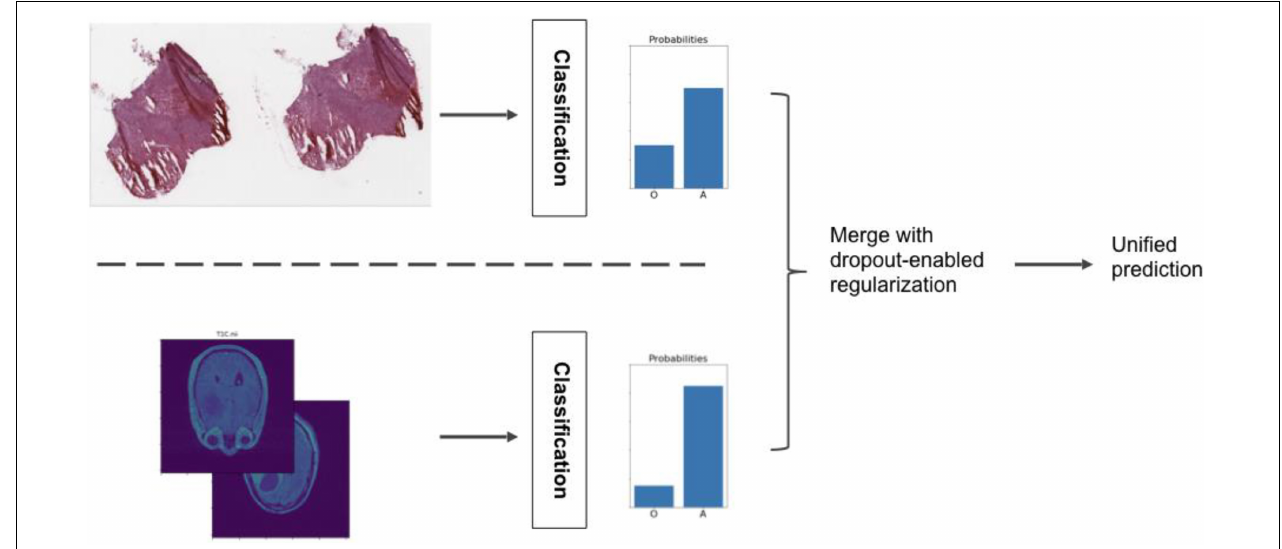
FIGURE 7 | Ensemble model that combines classifications from the radiology and histopathology image analysis